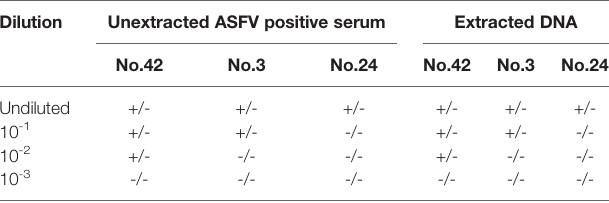
TABLE 5 | A Direct application of serum samples without DNA extraction and tested on the duplex iiPCR. Sample